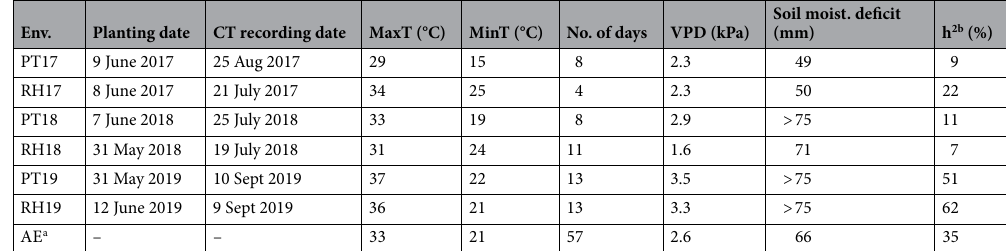
Table 1. Planting date and weather data including maximum temperature (MaxT), minimum temperature (MinT), No. of days without rainfall, estimated vapor pressure deficit (VPD), and estimated soil moisture deficit at the time of canopy temperature measurements for the field experiments conducted at Pine Tree (PT) and Rohwer (RH) in 2017, 2018, and 2019. a AE denote averaged across environments. b h 2 narrow sense